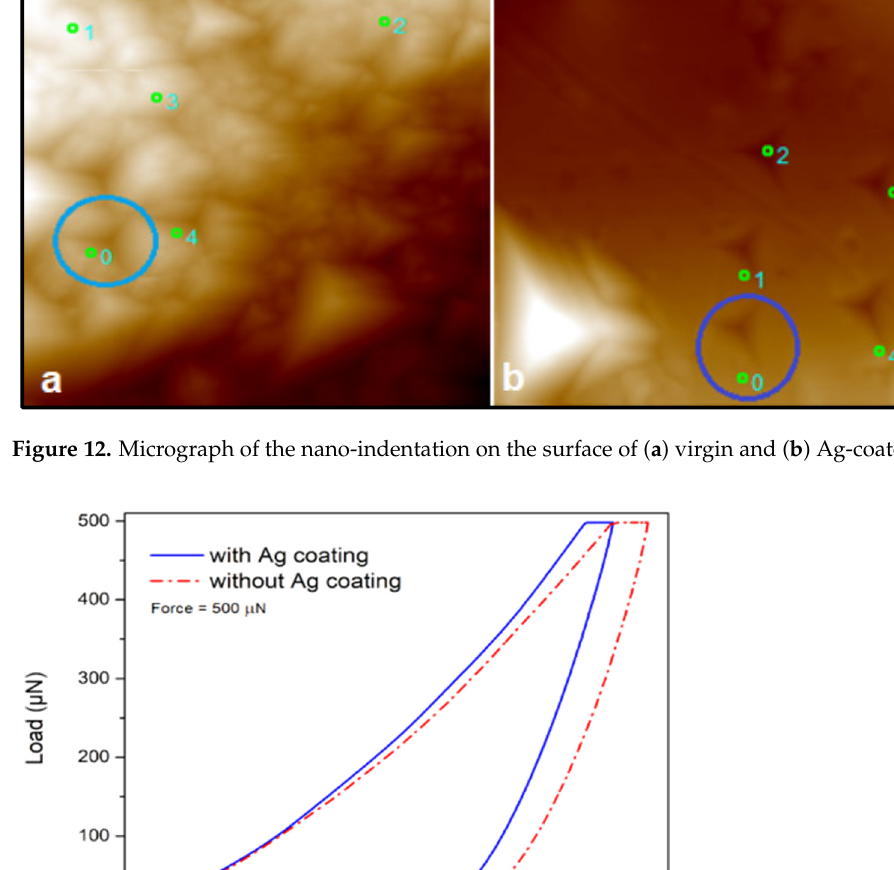
Figure 11. XPS spectrum for ( a ) oxygen and ( b ) silver, on surface of Ag-coated and virgin pellets .